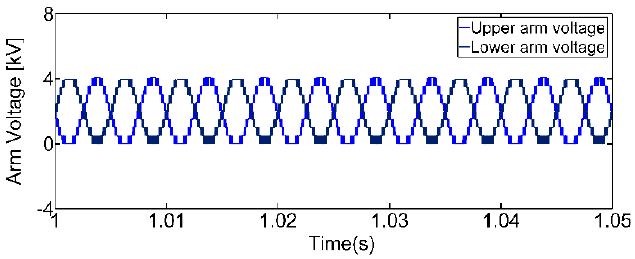
Figure 7. The upper arm and lower arm voltages in the proposed DC-DC MMC.